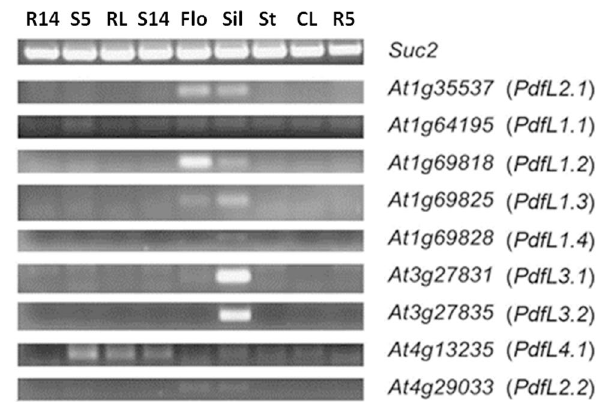
Figure 4. RT-PCR for all CRP0240 genes in different Arabidopsis tissues. R14 roots 14 days on MS medium, S5 seedlings 5 days MS, RL rosette leaves 5 weeks, S14 seedlings 14 days MS, Flo flowers, Sil siliques, St stems, CL cauline leaves, R5 roots 5 days MS. Total RNA was transcribed using oligo-dT and superscriptIII reverse transcriptase and amplified using gene-specific primers placed on both sides of the intron. Specificity of the reaction was tested with genomic DNA [shown on full-length gels in Figure